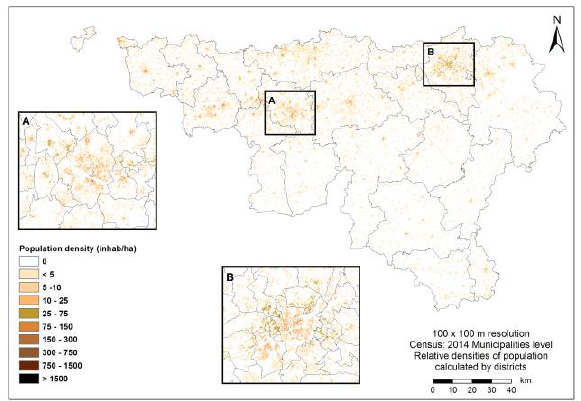
Figure 1. Classification methods: accuracies and illustrations (Van De Kerchove et al., 2015)